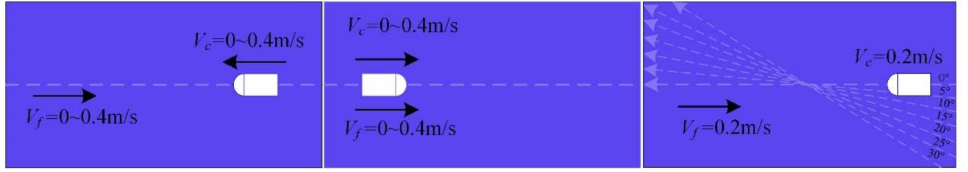
Figure 2. Schematic diagram of working conditions between the fluid velocity ( V f ) and carrier speed ( V c